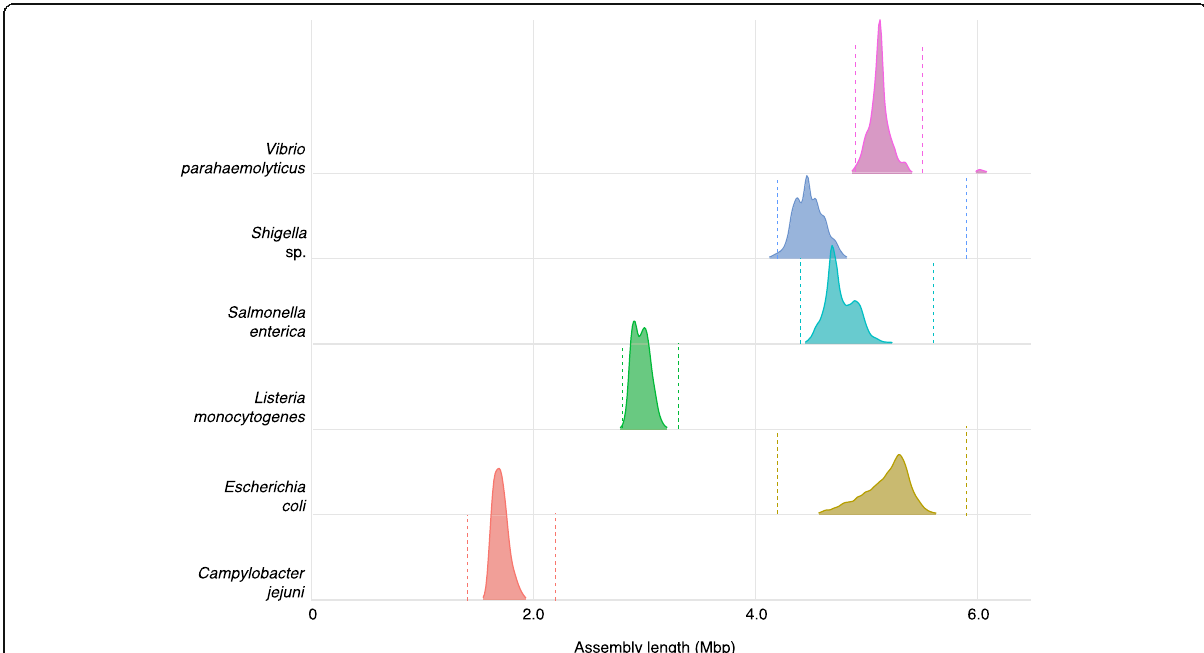
Fig. 3 Density plot showing the distribution of genome lengths for a random sample of isolates with Illumina sequence data available from NCBI Pathogen Detection portal ( n = 10,000 for all species except V . paramaemolyticus where n = 1414 due to smaller number of samples). Sequences were assembled using SKESA 2.2 and the bars indicate ±3 standard deviations from the mean. Mbp = mega base